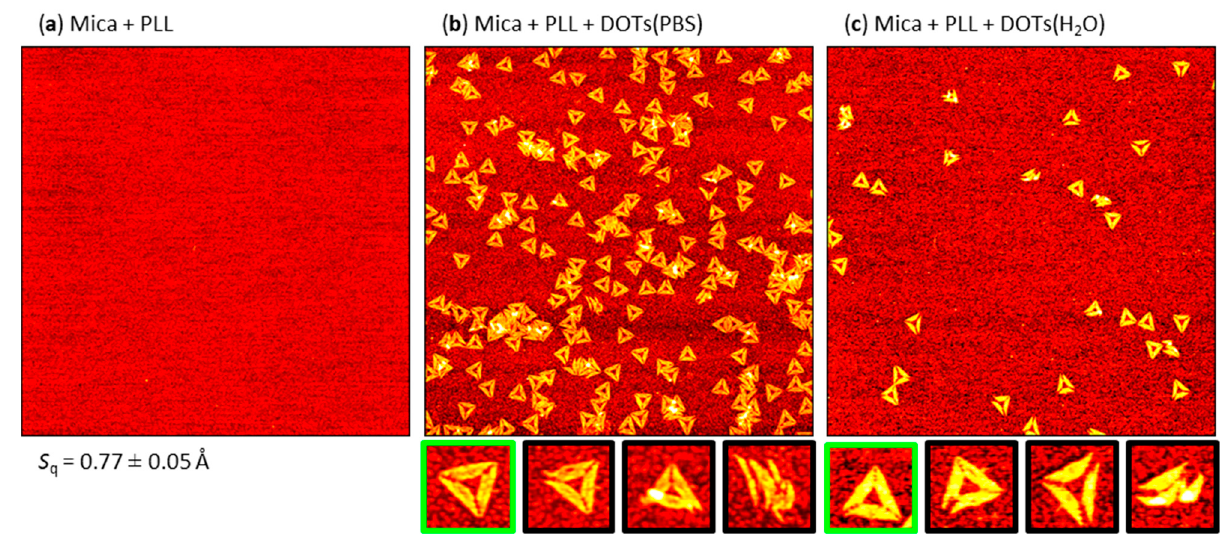
Figure 5. Representative AFM images of ( a ) a mica surface after incubation with PLL and DOTs adsorbed from ( b ) PBS and ( c ) H 2 O at the PLL-modified mica surface. The AFM images have a size of 3 × 3 µm² and a height scale of ( a ) 1.5 and ( b , c ) 2.5 nm, respectively. The RMS roughness S q of the PLL-modified mica surface (average of three AFM images ± standard deviation) is given below the AFM image in ( a ). Below ( b ) and ( c ), example magnifications of intact (green) and damaged (black) DOTs are shown.